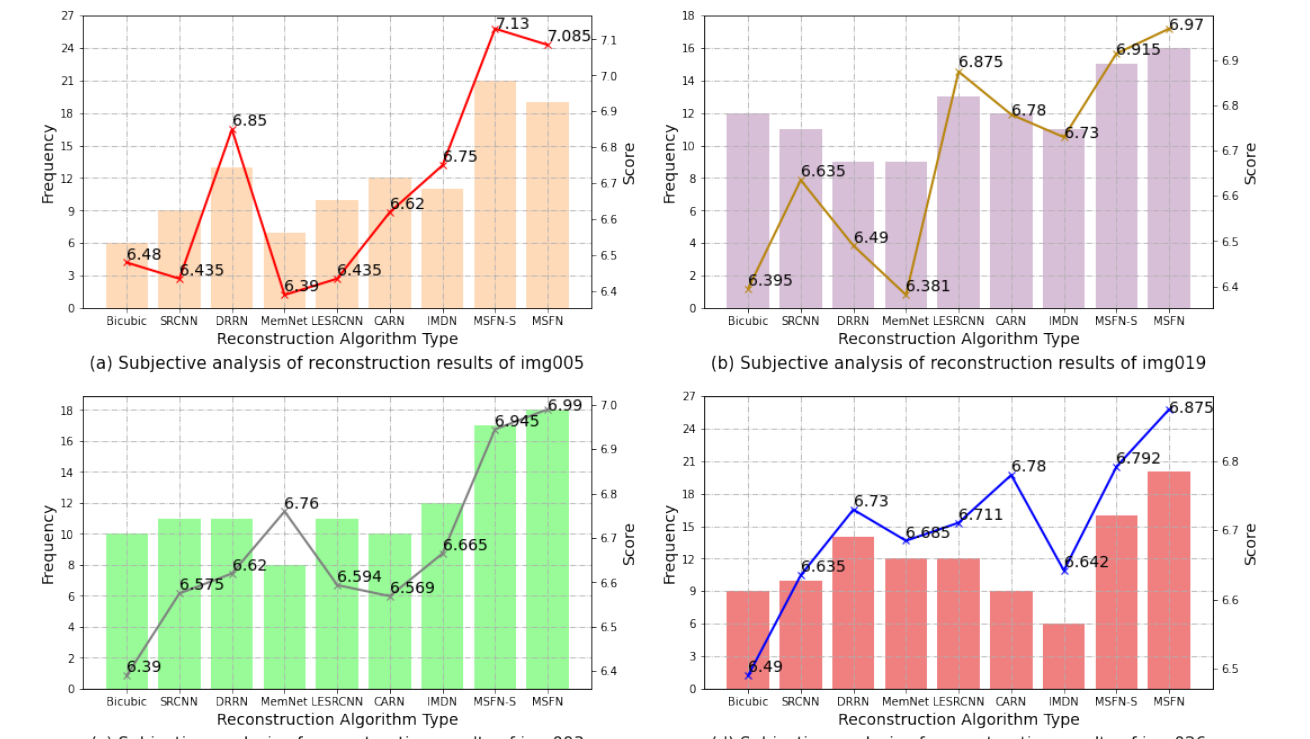
Figure 10. Subjective analysis of different reconstructed images. ( a ) Subjective analysis of recon- struction results of img005; ( b ) subjective analysis of reconstruction results of img019; ( c ) subjective analysis of reconstruction results of img093; ( d ) subjective analysis of reconstruction results of